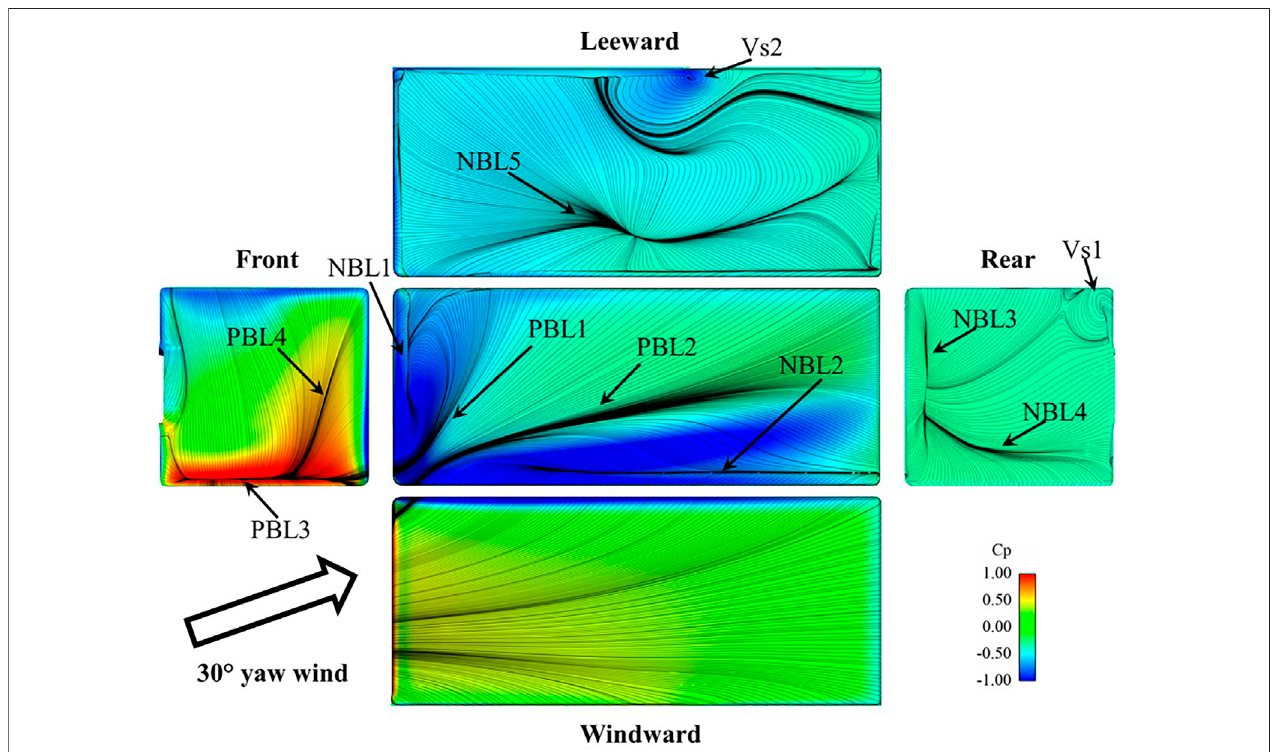
FIGURE 11 | Surface pressure contour and trace line of lorry one